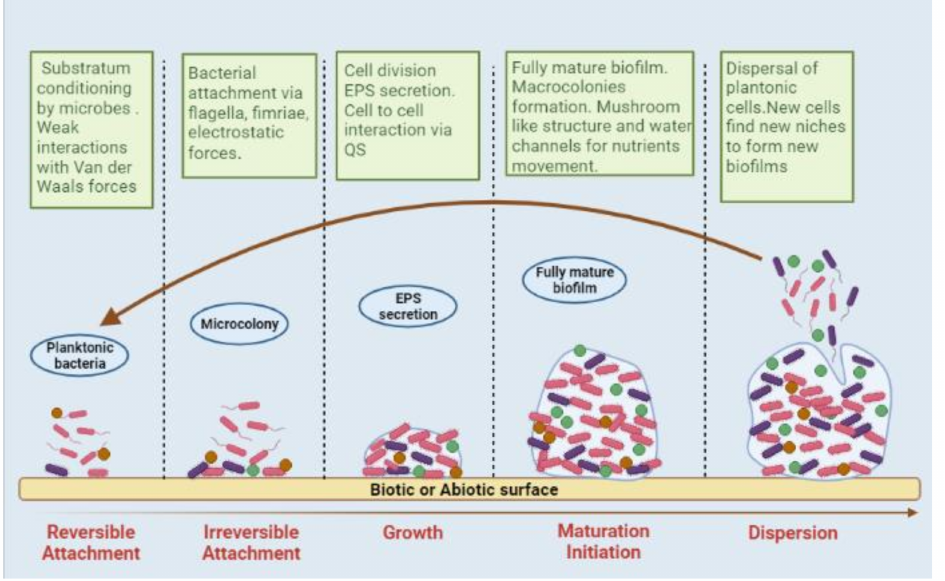
Figure 1. Schematic diagram of various steps involved in the biofilm formation